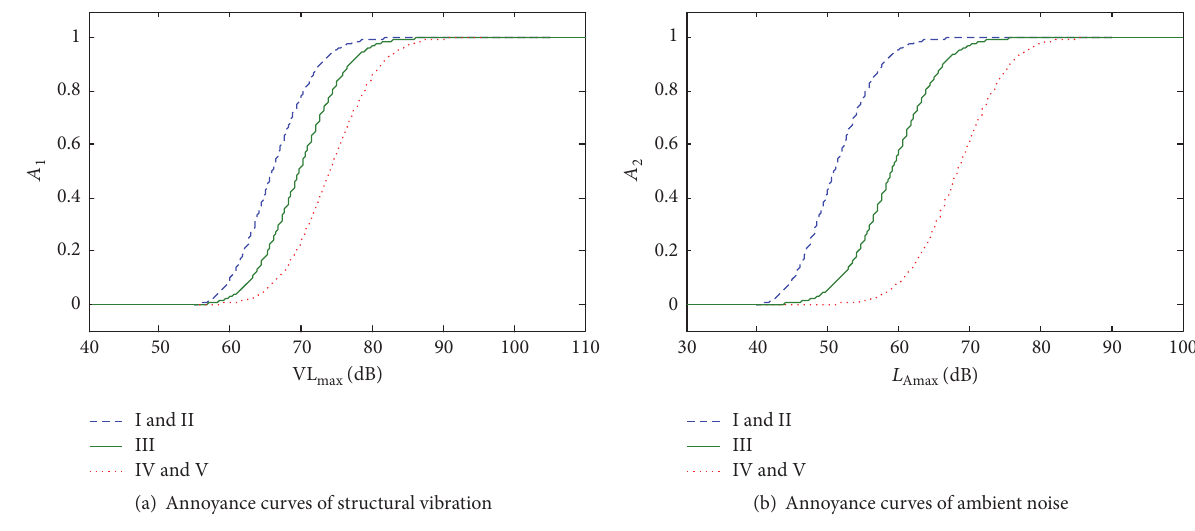
Figure 1: Daytime annoyance curves for typical areas.